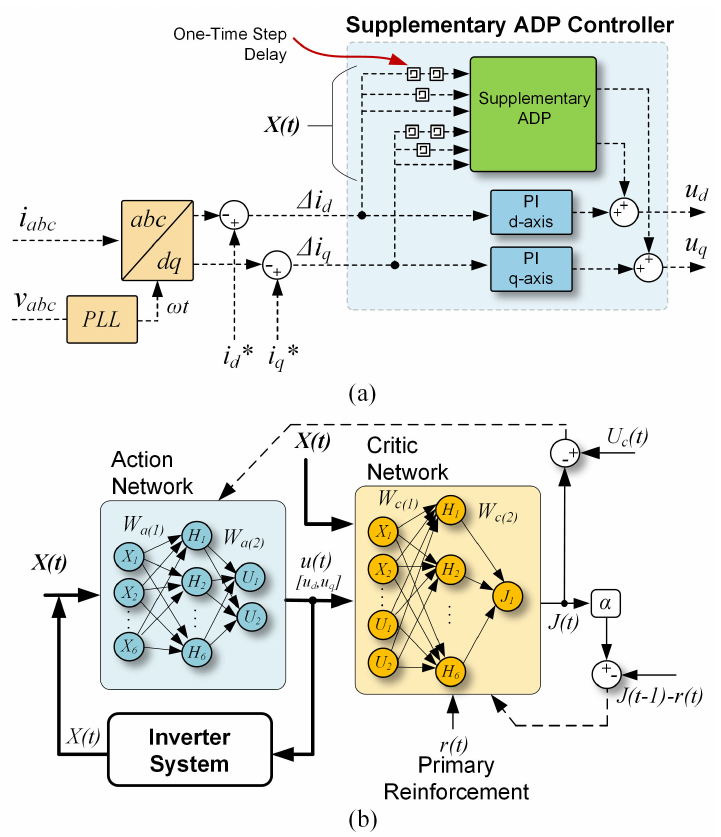
Figure 6. Supplementary ADP (adaptive dynamic programming) controller. ( a ) Schematic diagram. ( b ) detailed structure showing the action and critic network.